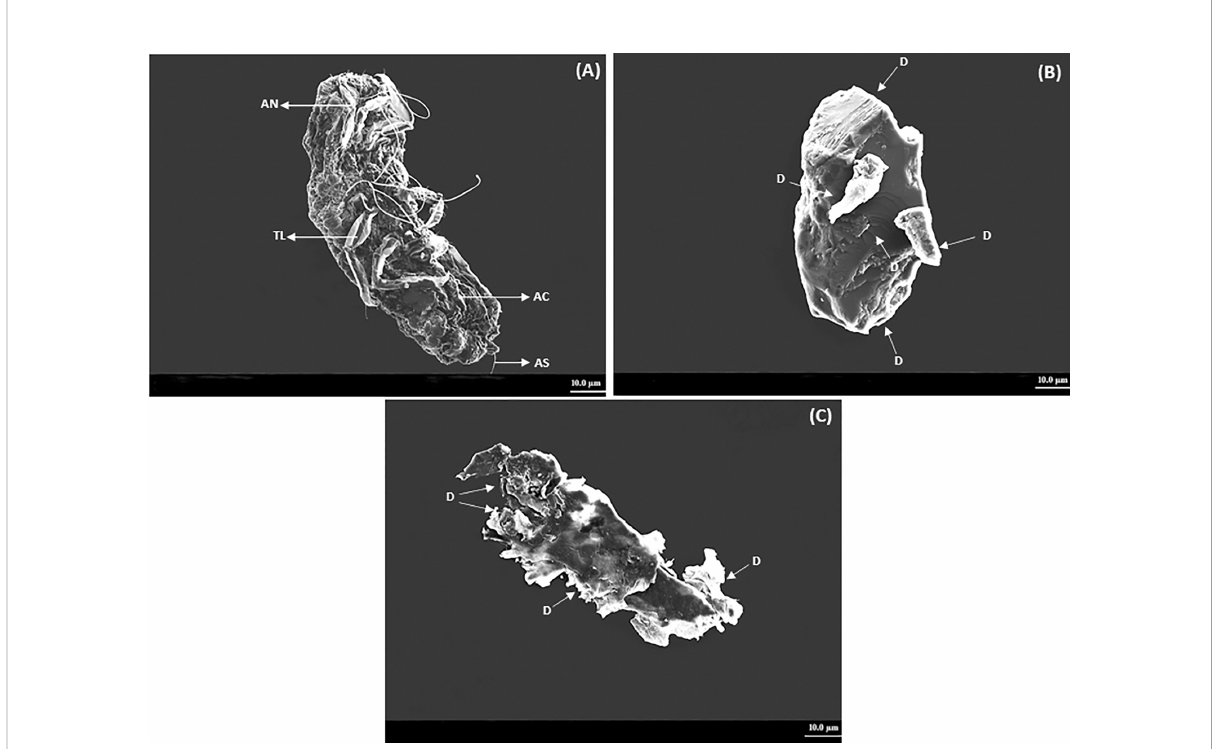
FIGURE 3 SEM analysis on deformities observed in P. lilacinus treated with ocimene. (A) Control, (B) 72 h after treatment, and (C) 96 h after treatment. AN, antenna; TL,thoracic leg; AC,abdominal cuticle; AS, abdominal setae; D, deformity or